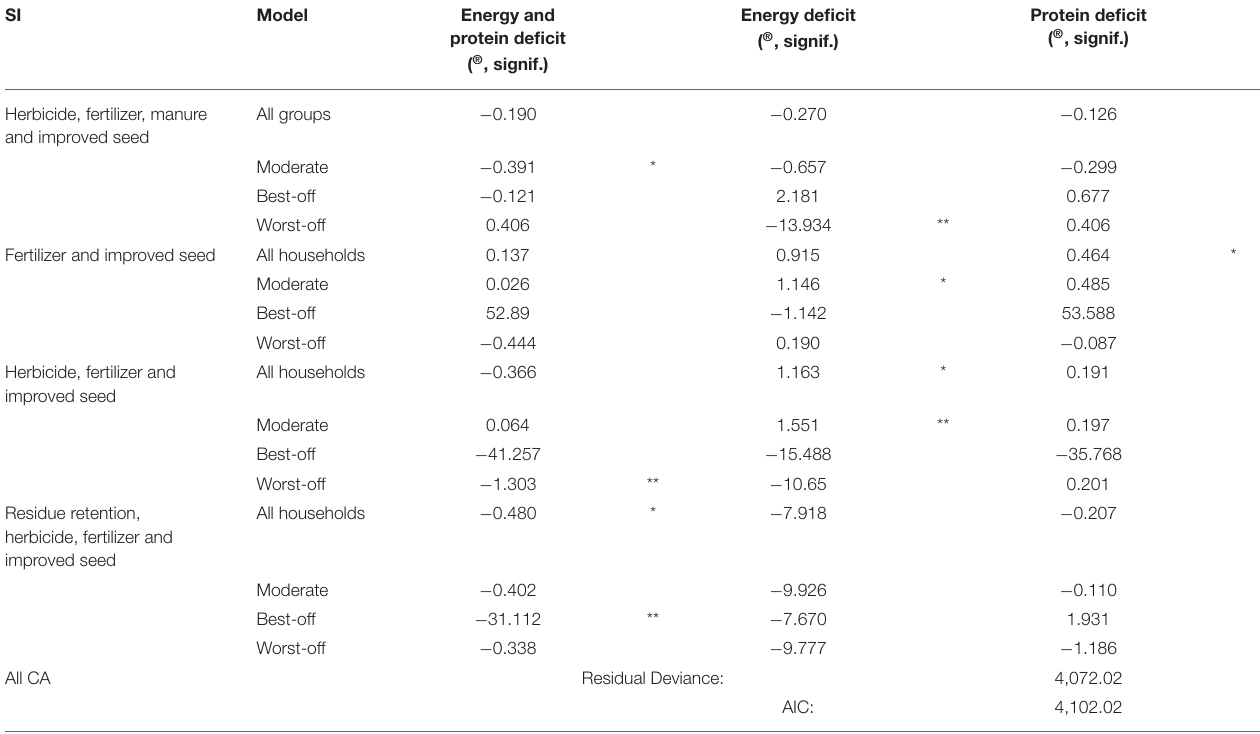
TABLE 5 | Multinomial logistic regression table showing sustainable intensification (SI) management practices associated with food availability in Ethiopia. SI Model Energy and